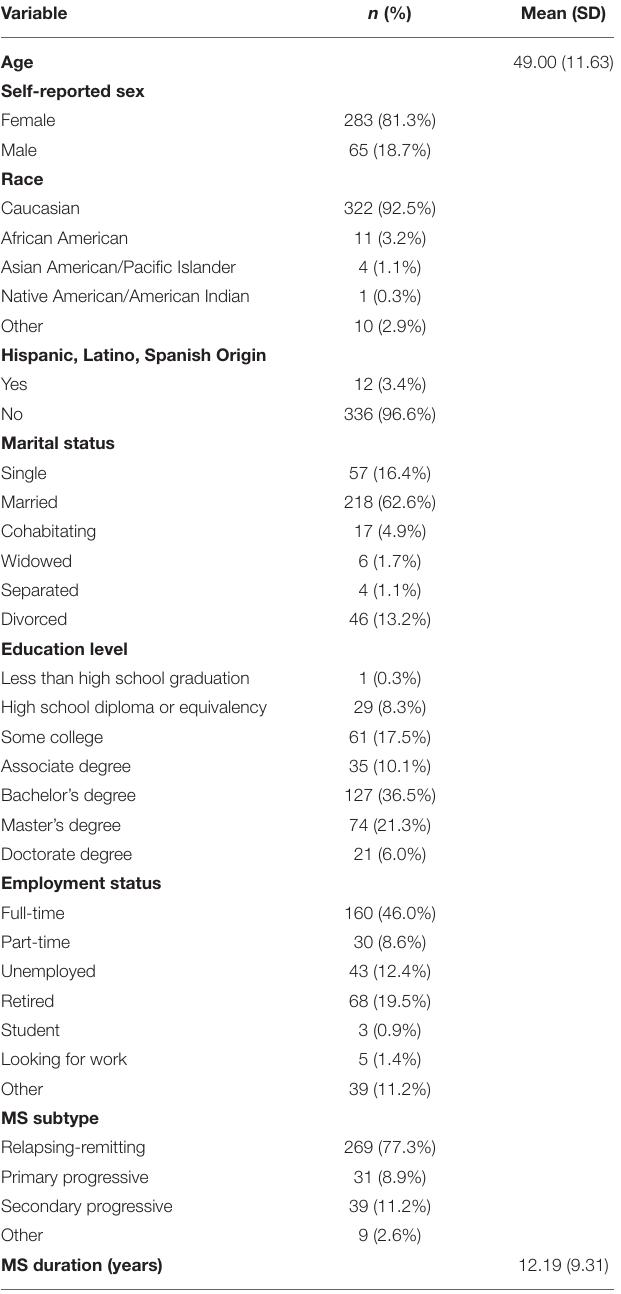
TABLE 1 | Participant demographic and MS characteristics ( N =